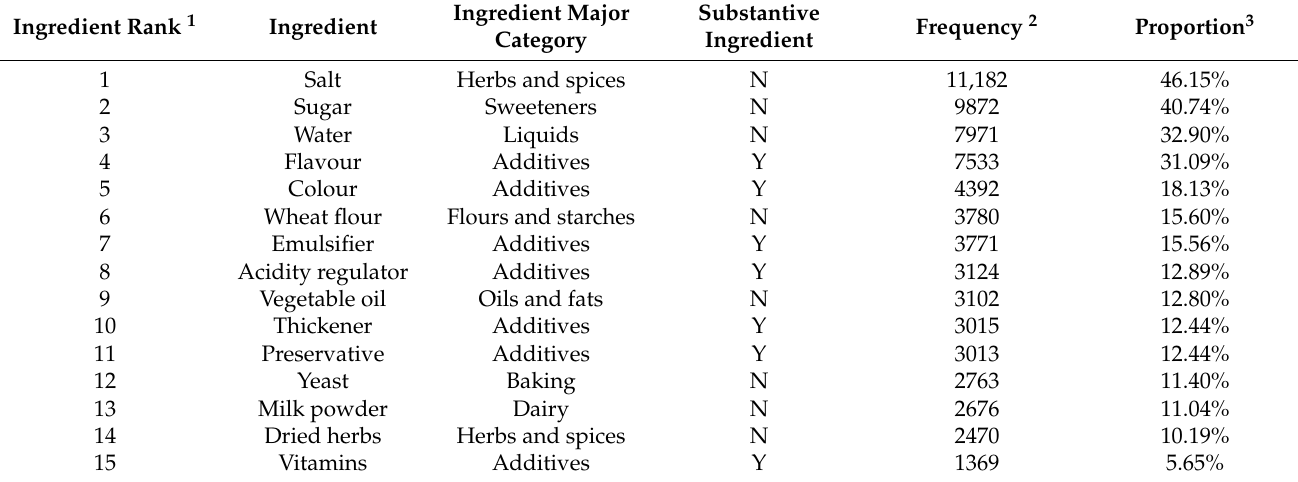
Table 2. The top 15 ingredients in the 2019 Australian packaged food and beverage